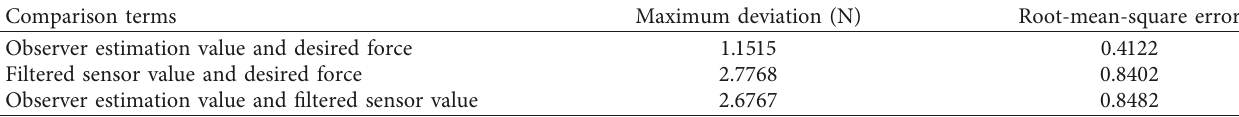
Table 5: Comparison of Z -direction force control errors in Figure 13(c).